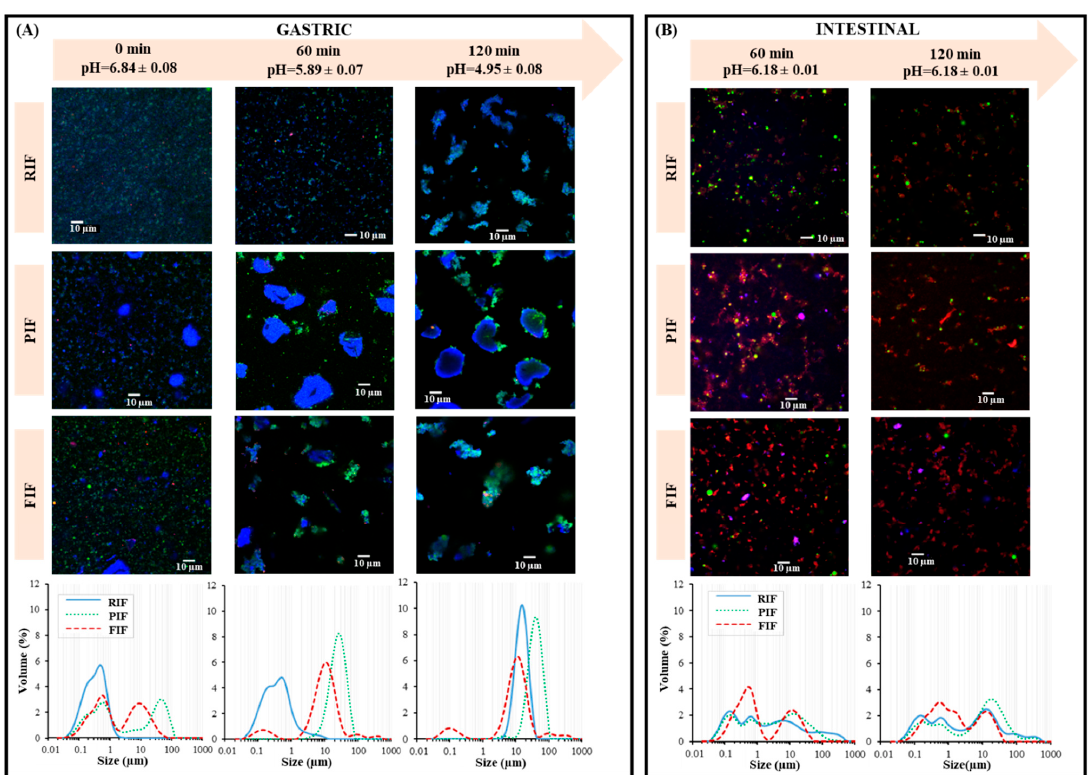
Figure 1. Confocal laser scanning microscopy images of RIF (reference infant formula), PIF (pea infant formula), and FIF (faba bean infant formula) in gastric ( A ) and intestinal ( B ) compartments over in vitro dynamic digestion and their corresponding particle size distribution profiles, as determined by laser light scattering. Proteins are colored in blue (FastGreen), apolar lipids in green (Lipidtox), and amphiphilic compounds in red (Rhodamine ‐ PE).